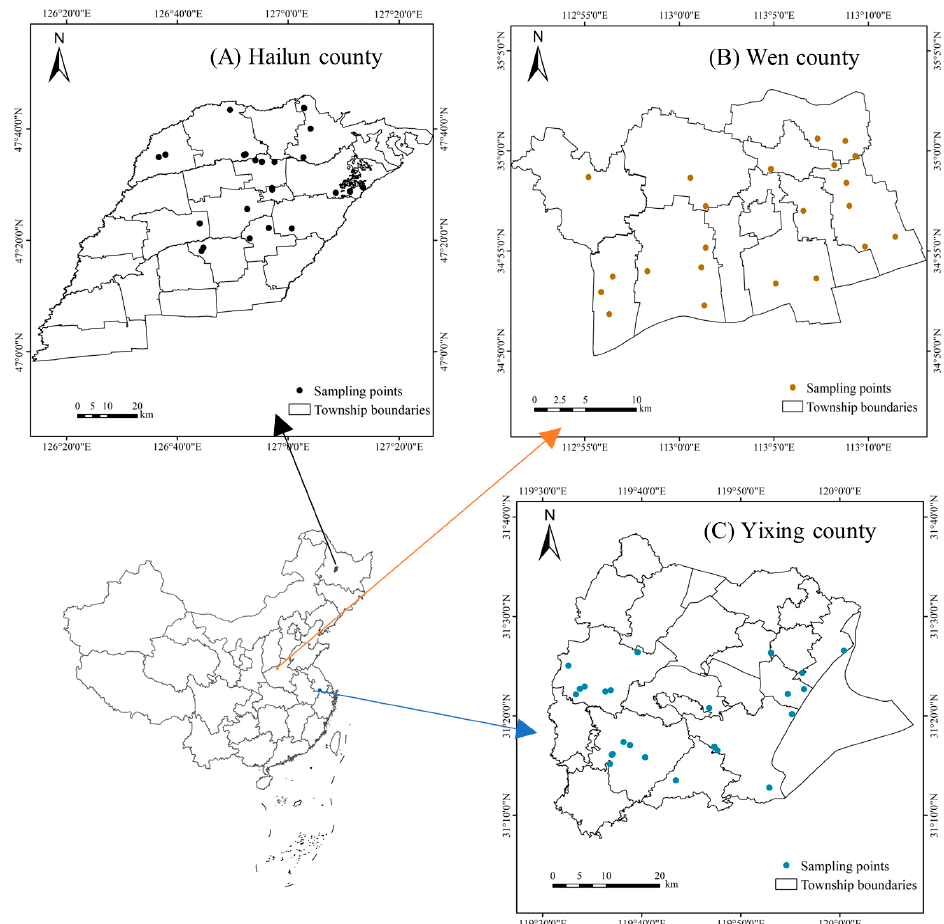
Figure 1. Location of the study areas and distribution of the sampling plots.